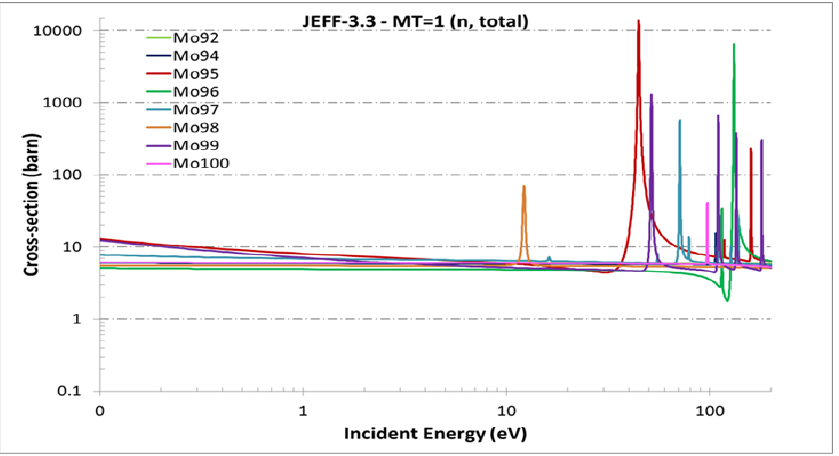
Figure 4. Mo isotopes total cross